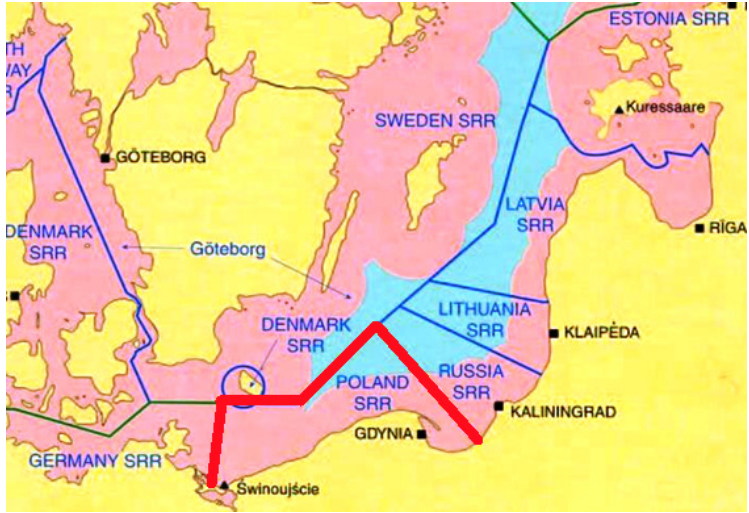
Figure 2. The Polish zone of maritime search and rescue responsibility in the Baltic Sea. The airspace over the Baltic Sea in the Polish responsibility zone is secured by an aircraft detached from the structure of the Polish Navy. The basic search and rescue vehicles covering the entire zone are rescue helicopters Mi-14 PS (Figure 3a), W-3R Anakonda (Figure 3b), and AN-28 airplanes. The SAR aviation system is provided by military aircraft and crewmen. The Polish state decided to detach navy resources to provide search and rescue capabilities. International acts clearly allow such activities, and at the national level it is possible under aviation law and decrees of the Minister of National Defense. The system operates on the basis of the ASAR Plan (it was developed by the Chairman of the Polish Air Navigation Services Agency (PANSA)). The ordinance indicates the search and rescue unit (SRU) operating within the system; their deployment is to ensure the functioning of rescue region (SRR), i.e., in our case, flight information region (FIR) Warsaw, 7 days a week, around the